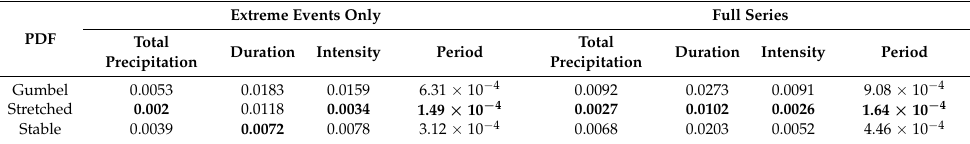
Figure 9. PDF distribution fittings for measurements of: Binion Creek discharge ( A ), North Creek discharge ( B ), depth to groundwater ( C ), and lake stage ( D ) using only the Log-Pearson Type 3 distribution (black lines) compared to the actual data (white circles w/black outline). Table 2. Root mean square error (RMSE) of each of the calculated distributions for the four storm properties, including both extreme values and full sets. The lowest RMSE is highlighted by bold font for each distribution.